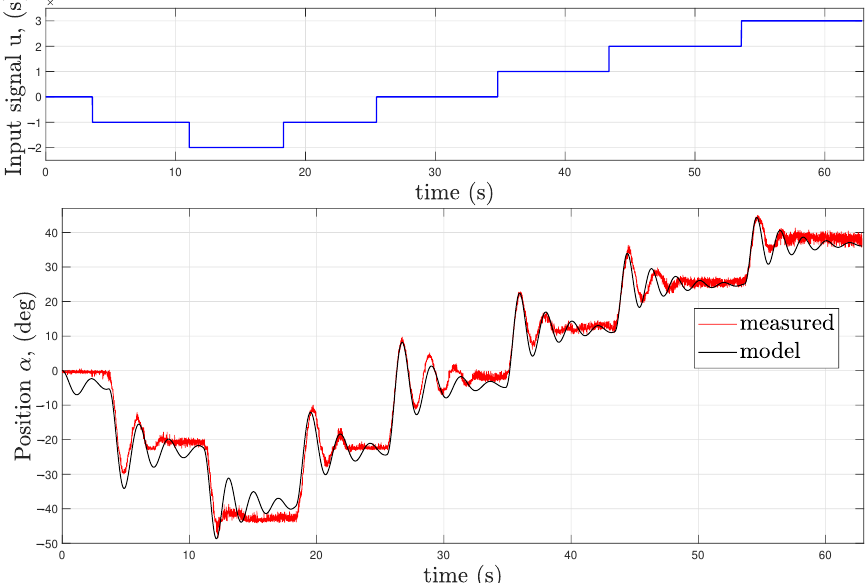
Figure 6. The output of the real and modeled